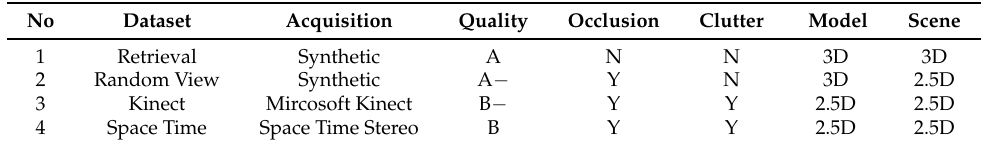
Table 3. Evaluation of four benchmark